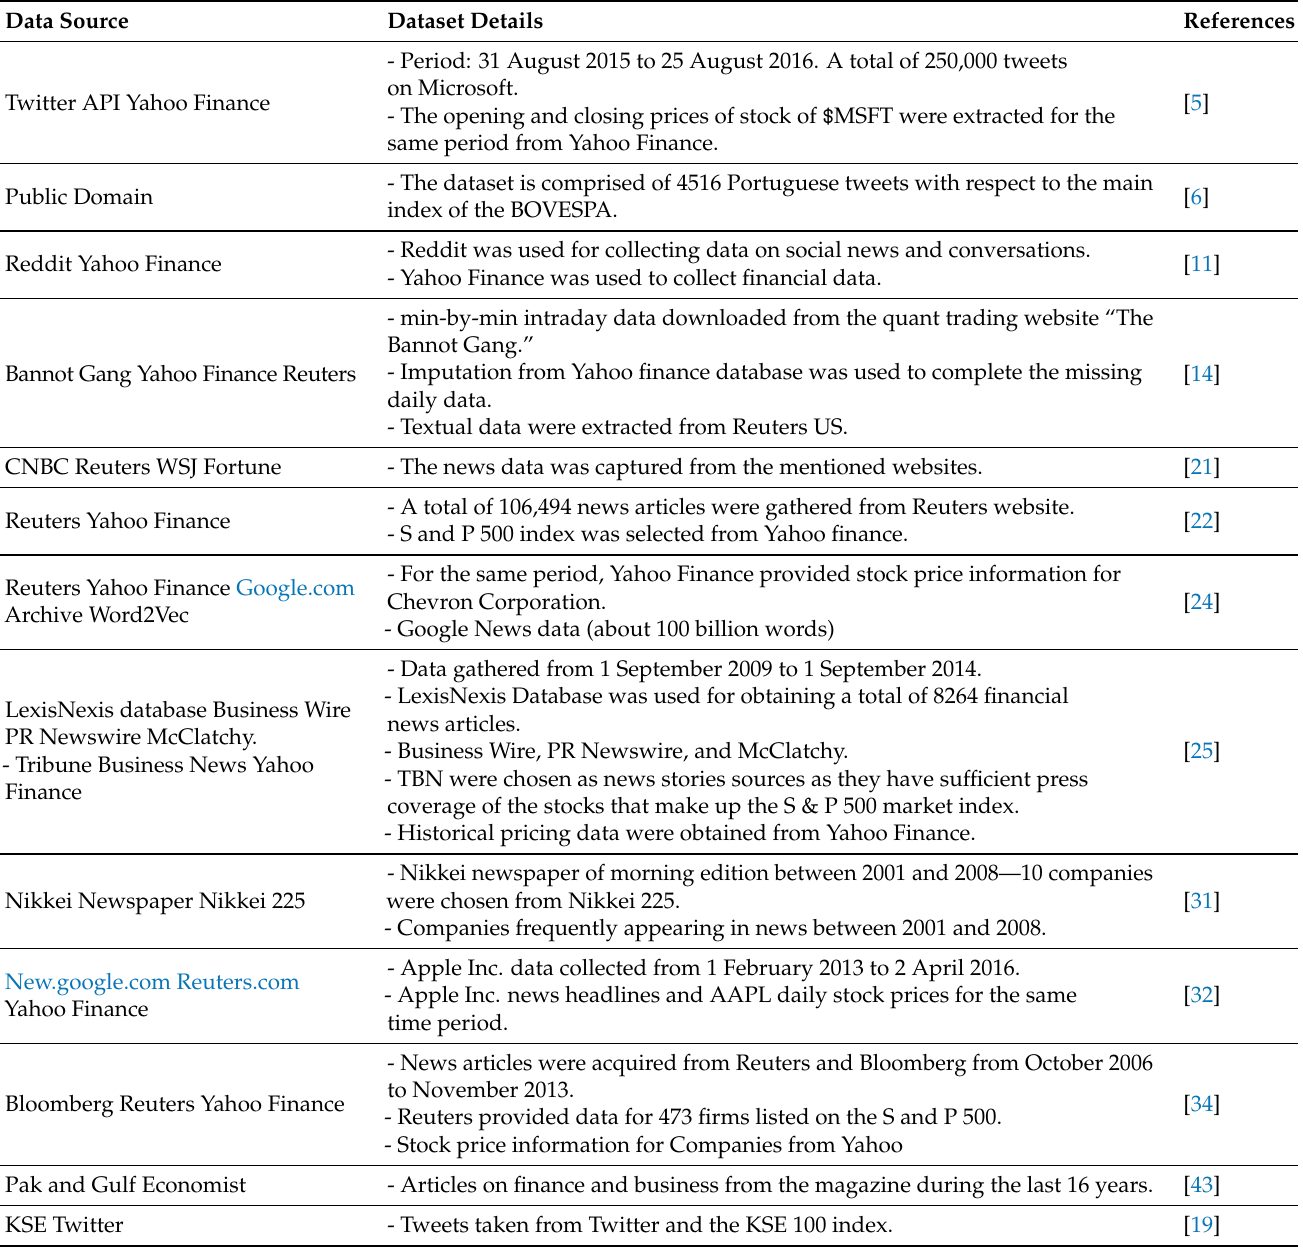
Table 3. The datasets utilised in different research